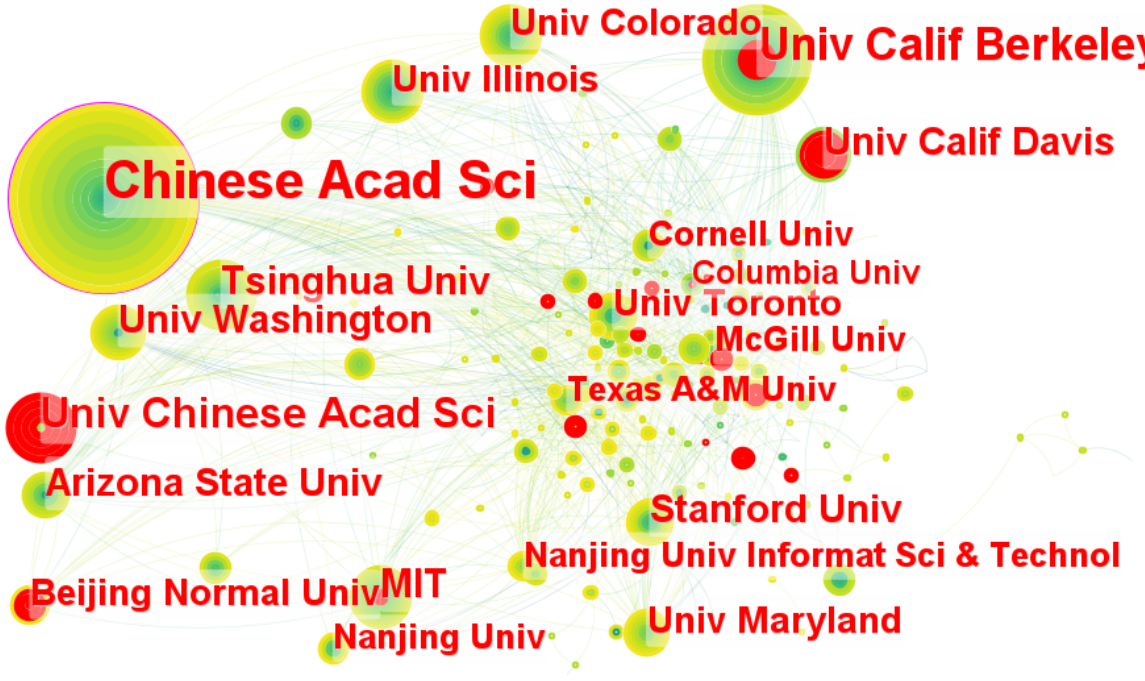
Figure 3. Institution collaboration network. Table 3. Top 10 institutions based on the number of publications.